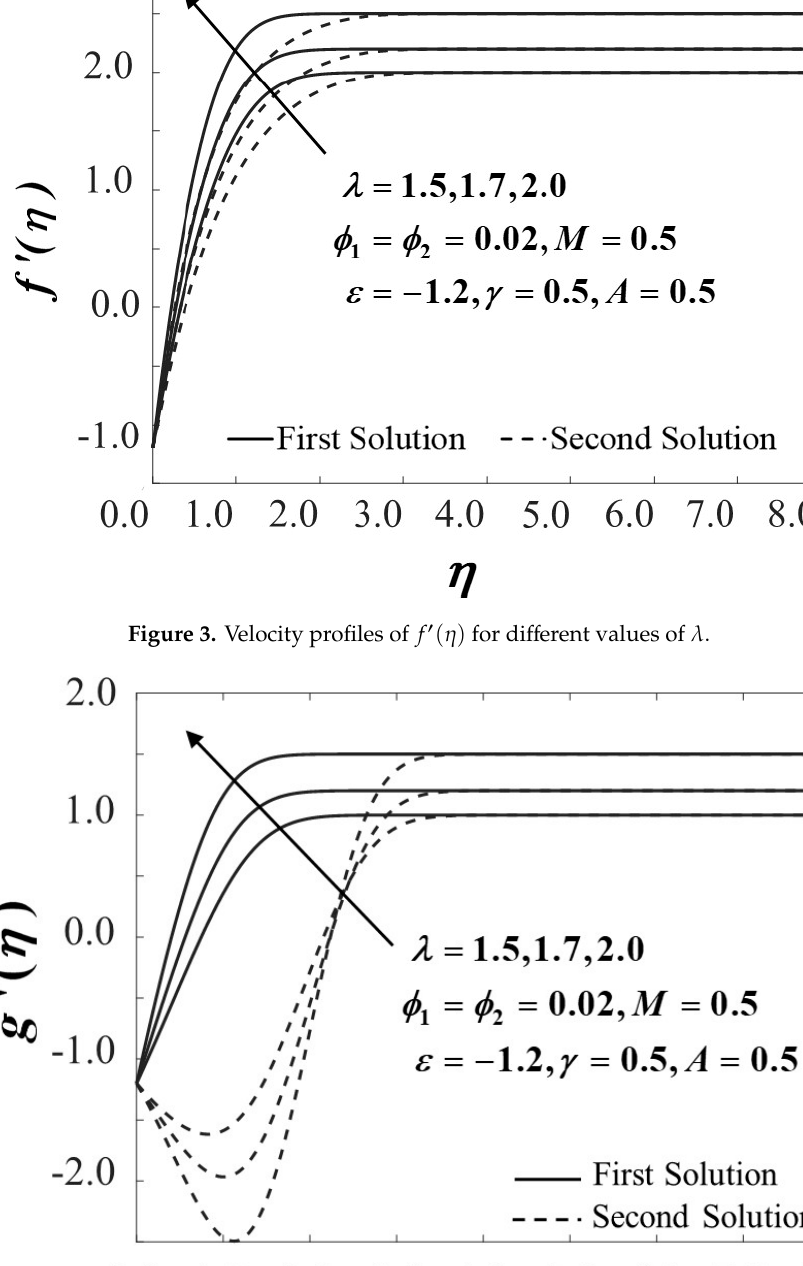
Figure 4. Velocity profiles of g (cid:48) ( η ) for di ff erent values of λ